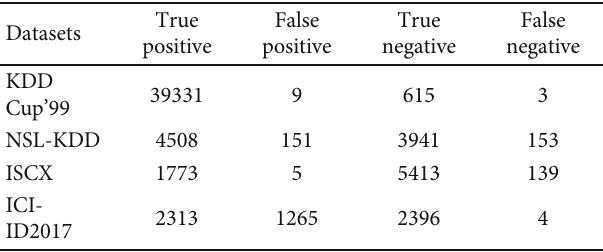
Table 6: Confusion matrix of SVM